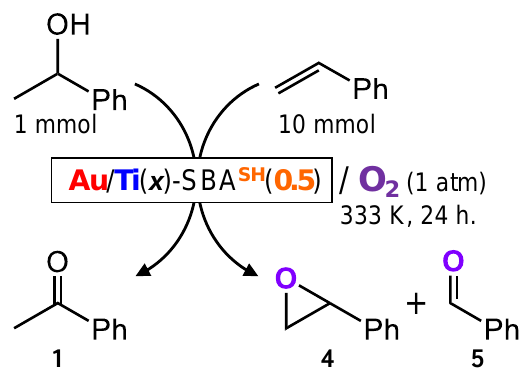
Table 4. Conversion of 1-phenylethanol mediated by the calcined catalysts under O 2 . Amount of Products/ µ mol Catalyst 1 4 5 Based on Ti Based on Au Au/Ti(0)-SBA SH (0.5) Au/Ti(0.5)-SBA SH (0.5) Au/Ti(1)-SBA SH (0.5) Au/Ti(2)-SBA SH (0.5)